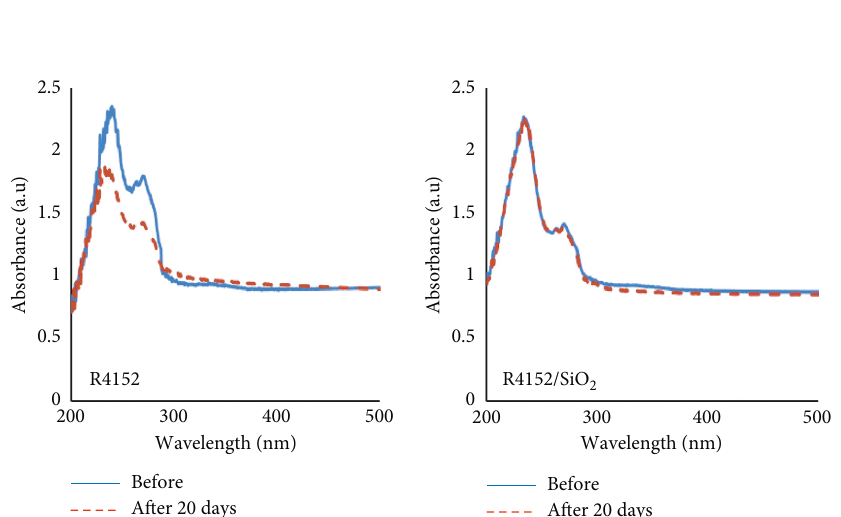
Figure 3: UV-Vis spectra of acrylic coating without SiO